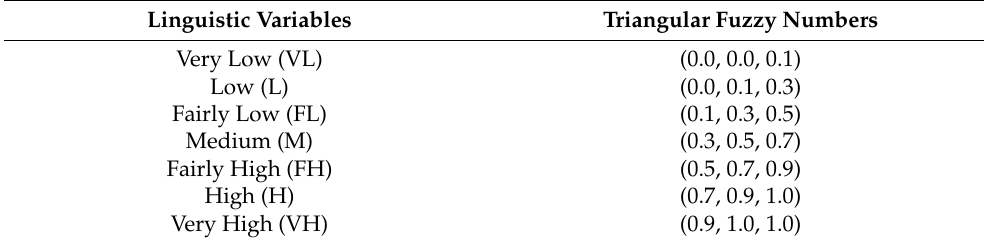
Table 4. Linguistic variables and their fuzzy numbers.